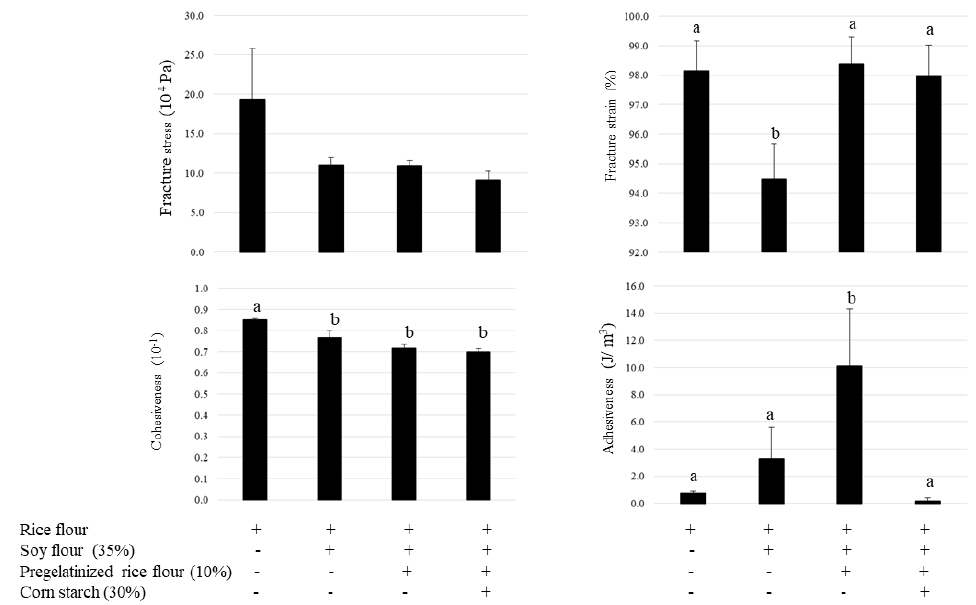
Figure 6. Effect of pregelatinized rice flour and cornstarch on bread texture. Data are shown as mean ± SD. Different letters indicate p < 0.05 between groups.